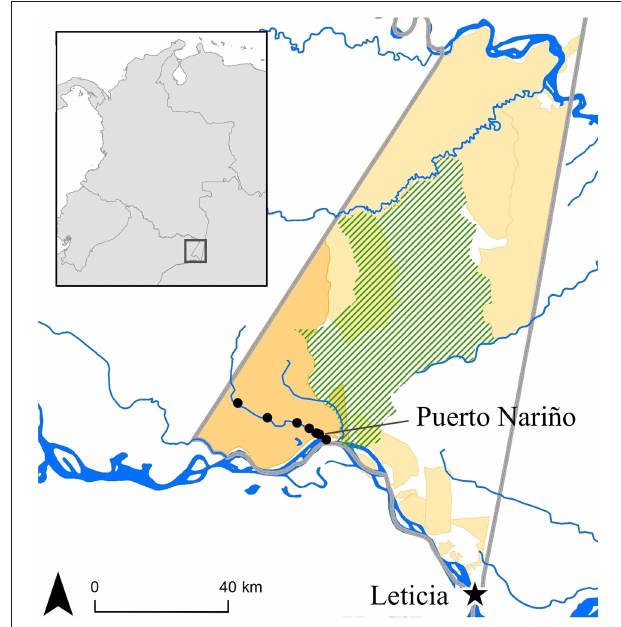
FIGURE 1 | Map of the Ticoya indigenous reserve (in dark orange) and its location in Colombia. Dots indicate the communities where the study was conducted, from right to left: Puerto Esperanza, Puerto Nariño, Ticoya, Santa Teresita, San Francisco, Doce de Octubre, and Tipisca. In green, partly overlapping the Ticoya reserve, the Amacayacu National Park. One workshop was organised in the proximity of Leticia along the National Route